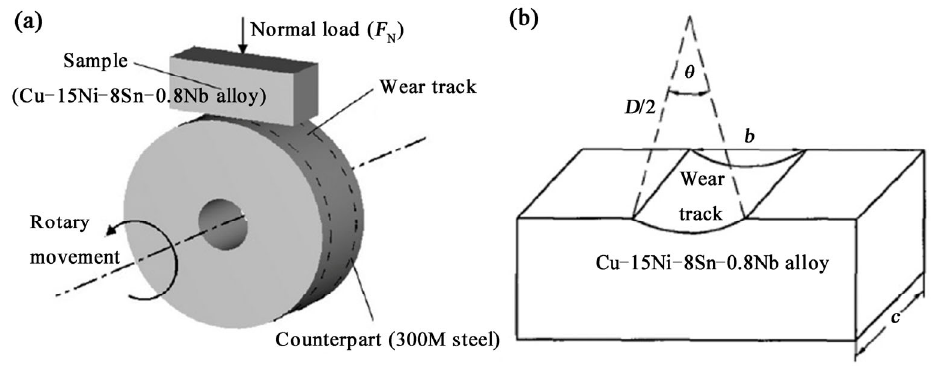
Fig. 1 Schematic of (a) friction pairs and (b) volumetric wear loss calculated by the average width of the wear